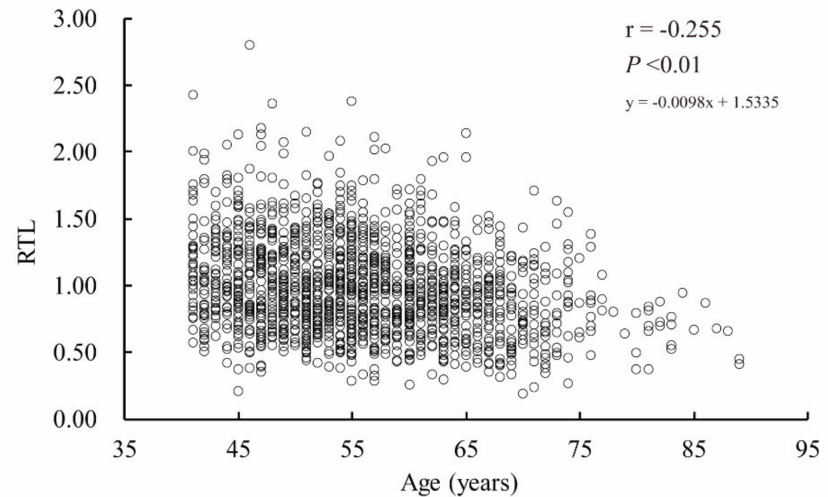
Figure A1. Scatter plot diagram to demonstrate correlation between relative telomere length (RTL) and